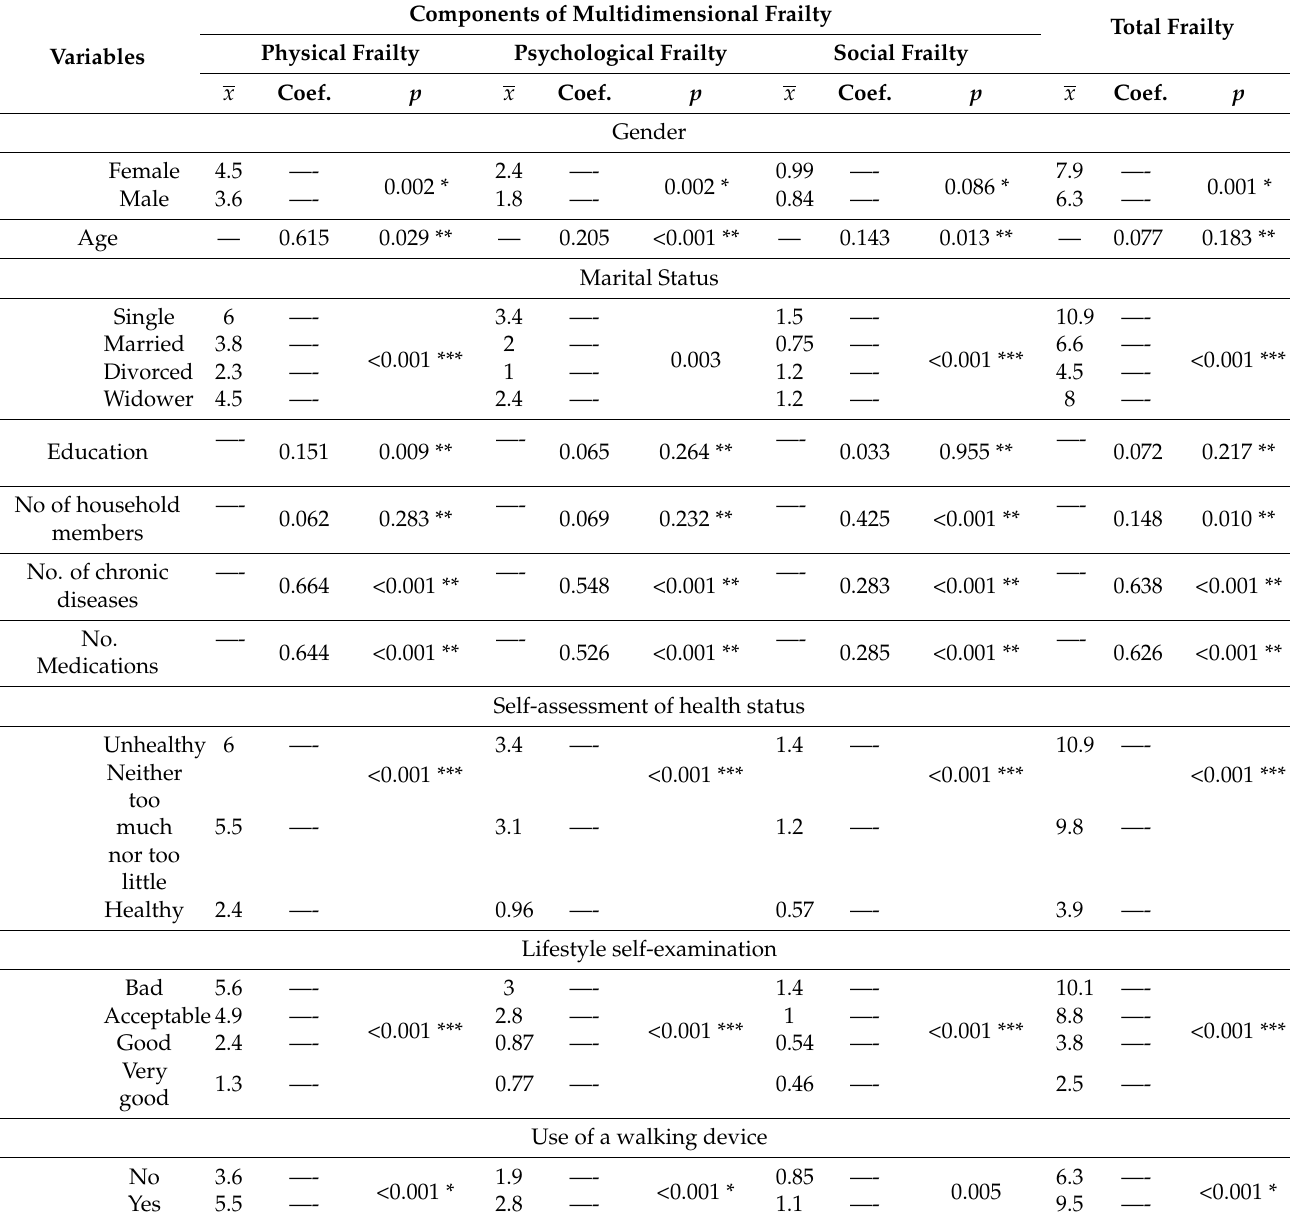
Table 4. Association between socio-demographic and clinical conditions with physical, psychological, social, and total frailty from